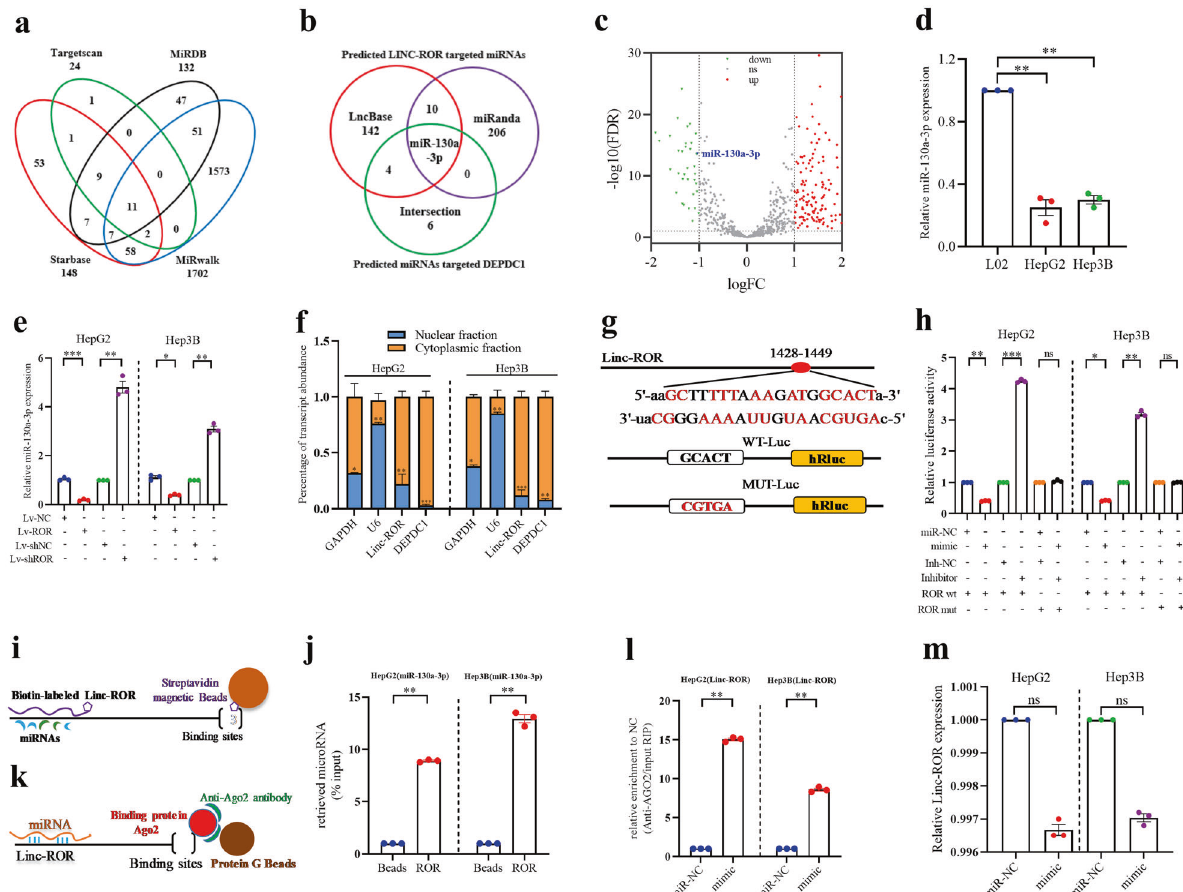
Fig. 2 Linc-ROR directly targets miR-130a-3p. a , b Venn diagram showing the potential miRNAs that target both DEPDC1 and Linc-ROR were predicted using the TargetScan, MiRDB, Starbase, miRWalk, LncBase, and miRanda databases. c Screening of differentially expressed miRNAs in the TCGA database. d The mRNA expression level of miR-130a-3p in a normal liver cell line (L02) and HepG2 and Hep3B cell lines were tested by quantitative qRT-PCR. e The mRNA levels of miR-130a-3p in HepG2 and Hep3B cells after transfection with Lv-ROR or Lv-shROR. f Localization of Linc-ROR and DEPDC1 was assessed by qRT-PCR in HepG2 and Hep3B cells. U6 and GAPDH were used as positive controls for nuclear RNA and cytoplasmic RNA, respectively. g Binding sequences of Linc-ROR and miR-130a-3p based on bioinformatics analysis and schematic constructions of WT-Luc (Linc-ROR 3 ʹ partial region), MUT-Luc. h Dual-luciferase reporter assays were performed to examine the potential combination of Linc-ROR and miR-130a-3p. i , j The schematic diagram of the RNA pull-down method used to identify the binding between Linc-ROR and miRNAs in both HepG2 and Hep3B cells; HCC cell lysates were incubated with biotin-labeled Linc-ROR, miRNA qRT-PCR was performed after the pull-down process. k , l Anti-AGO2 RIP was performed in HepG2 and Hep3B cells transfected with miR-130a-3p mimics or miR-NC, followed by qRT-PCR to detect Linc-ROR enrichment. m The relative expression of Linc-ROR in HepG2 and Hep3B cells transfected with miR-130a-3p mimics. Data are shown as mean ± SD, n = 3. The data statistical signi fi cance is assessed by Student ’ s t test. * P < 0.05, ** P < 0.01, *** P < cystadenocarcinoma showed the most markedly elevated expression of Linc-ROR in tumors compared with non- cancerous tissues among all examined cancers (Fig. 1a). Similar results were observed in LIHC of the CCLE dataset (Fig. 1b). Linc-ROR was highly expressed in TCGA-LIHC and matched normal samples and GTEx tissue samples (Fig. 1c). These results were in accordance with a previous report [19, 20], indicating that Linc-ROR functions as an oncogene in LIHC. The sequence of Linc-ROR displayed a high level of conservation across 33 mammalian species (Supplementary Fig. s1a). Consistent with Linc-ROR being a non-coding RNA, The Coding Potential Assessment Tool (http://lilab.research.bcm.edu/cpat/index.php) [33] predicted that Linc-ROR has a very low coding potential, similar to SCHLAP1, an lncRNA (Supplementary Fig. s1b). Subcellular fraction analysis by Lnclocator (http://www.csbio.sjtu.edu.cn/bioinf/lncLocator/) [34] and iLoc-lncRNA (http://lin-group.cn/server/iLoc-LncRNA/predictor.